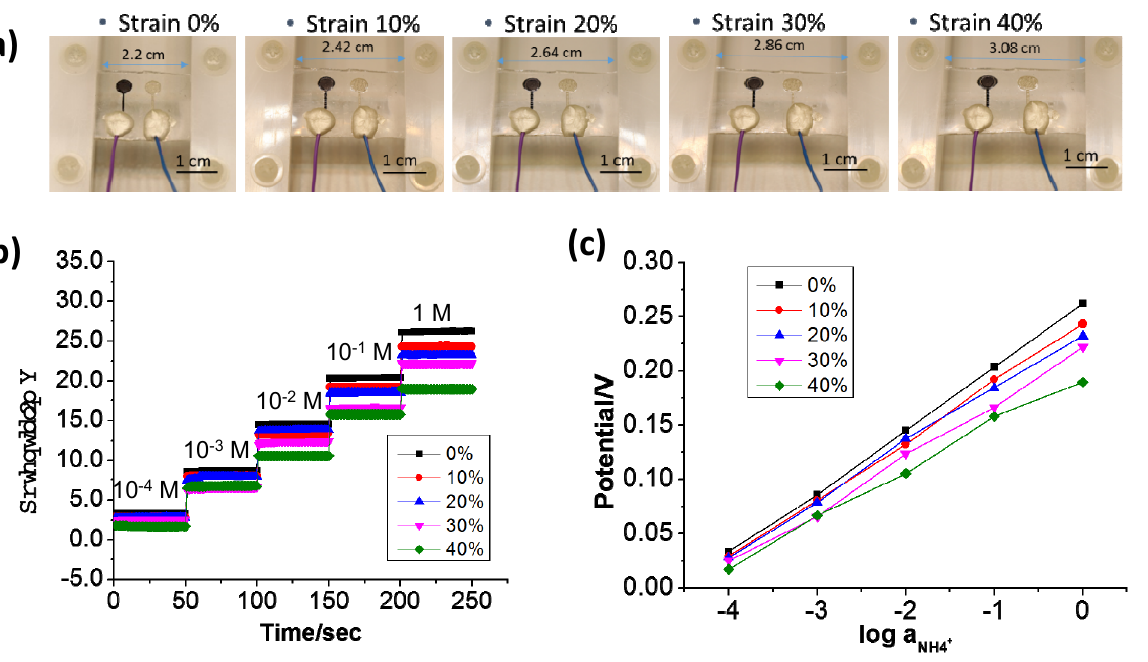
Figure 10. ( a ) Photographs of the 3D Graphene–CNT sweat sensor at different strains (0–40%); ( b ) Potentiometric output of the sweat sensor under a series of NH 4 Cl solutions with different concentrations (10 − 4 M to 1 M); ( c ) Averaged potentiometric output as a function of the concentration of NH 4+